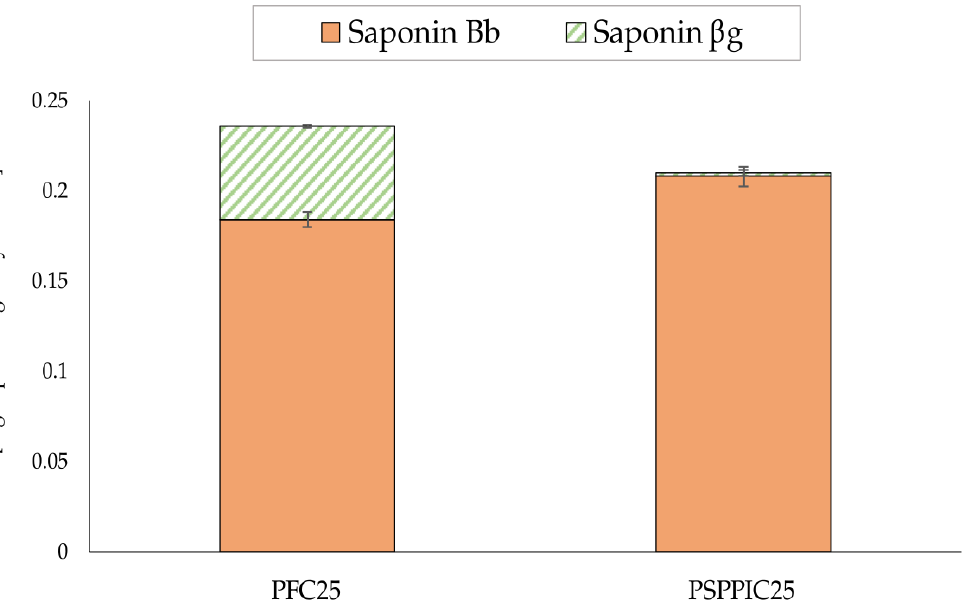
Figure 2. Comparison between the saponins extracted from cakes baked at 170 °C for 25 min: PFC25 = pea flour cake and PSPPIC25 = reconstituted flour cake made of PS + PPI. Saponin βg is represented in striped green and saponin Bb in orange.